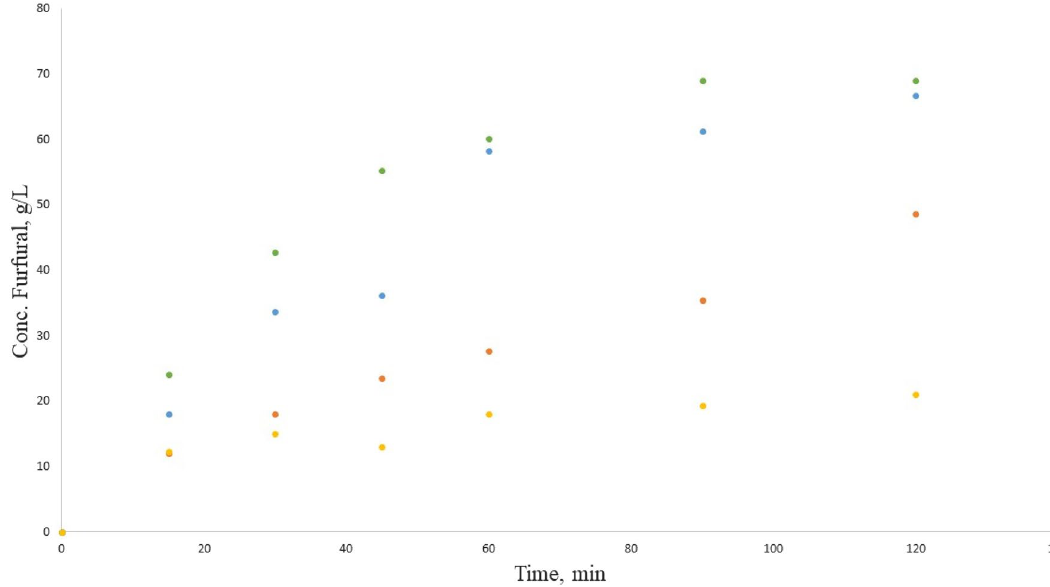
Figure 6. Furfural production in the Maillard reaction with CaCl 2 , from orange pectin (blue circle), tangerine pectin (green circle), mango pectin (orange circle) and tamarind pectin (light orange